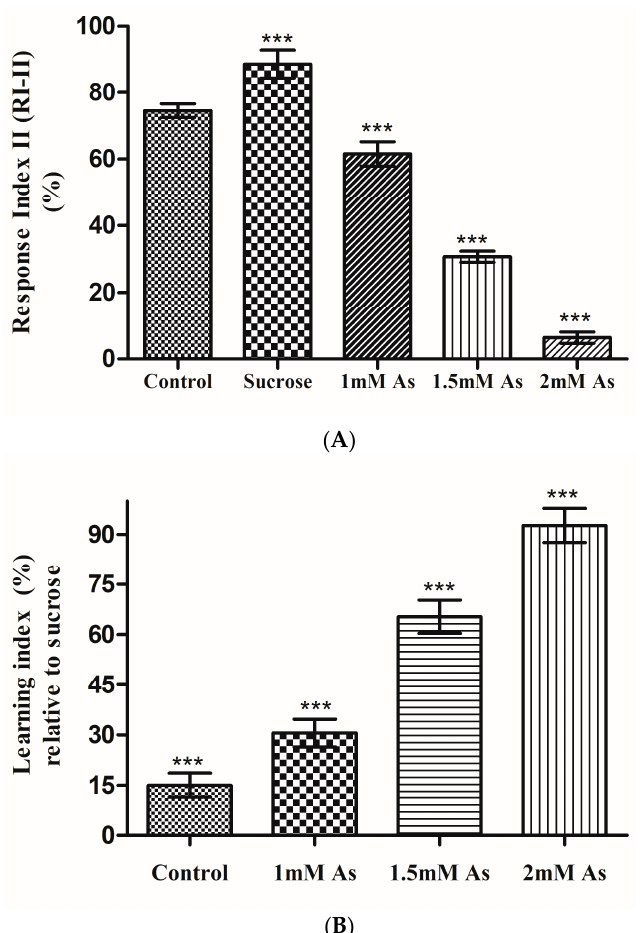
Figure 7. ( A ) The bar graph represents the response index-II of the control flies, sucrose untreated flies, treated flies at 1 mM As, 1.5 mM As, and 2 mM As. The error bar represents the means ± S.D. The significant mean difference ( p < 0.05) between RI-II mean of the different sample of flies was analyzed by a one-way analysis of variance (ANOVA) (*** p < 0.0001; R squared = 0.974. ( B ) The bar graph represents the learning index of arsenic-treated flies and control flies relative to untreated sucrose flies, with the error bar representing the means ± S.D. The significant mean difference ( p < 0.05) between the flies’ sample mean was analyzed by a one-way analysis of variance (ANOVA) (*** p <0.0001).